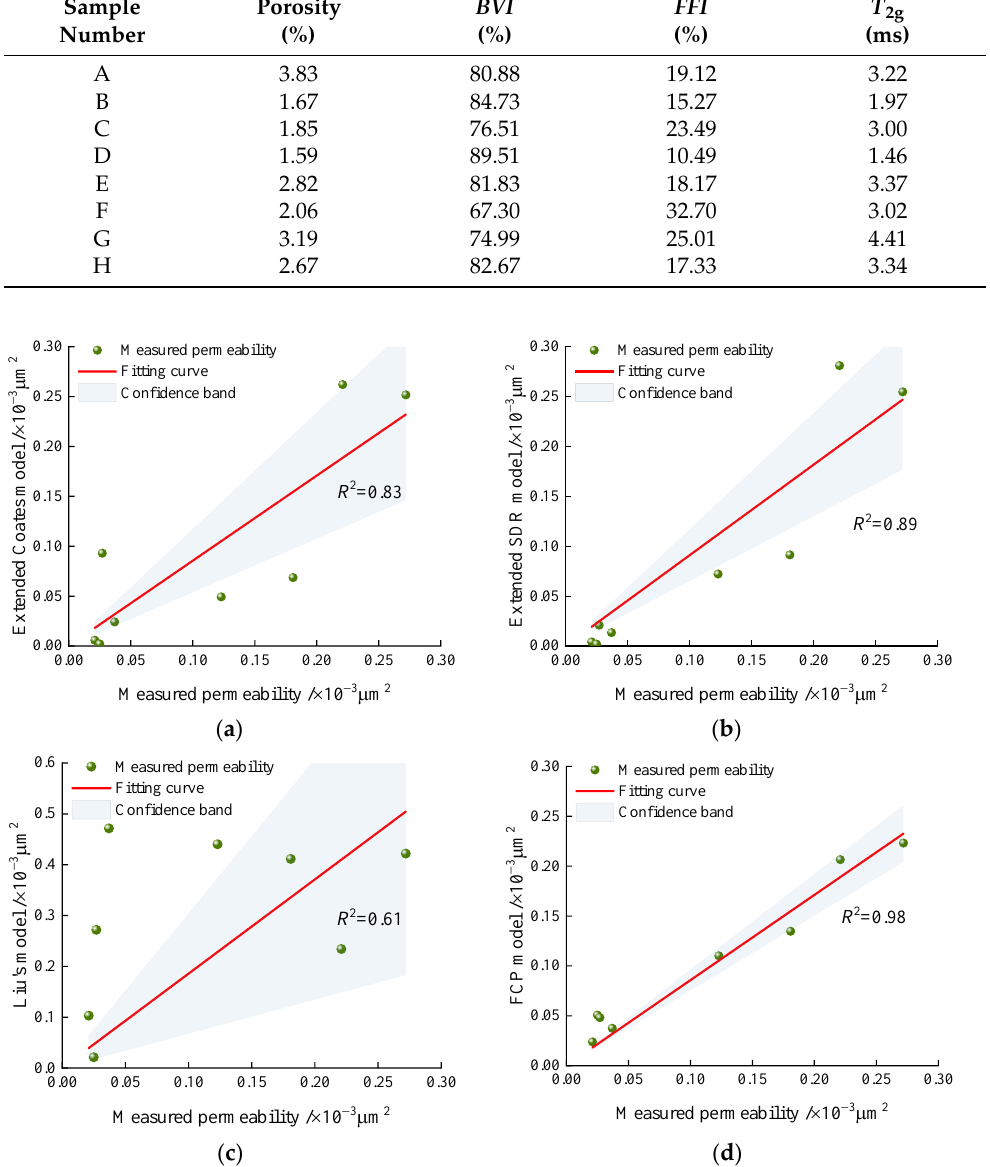
Table 3. Parameters of the Coates model and the SDR model.